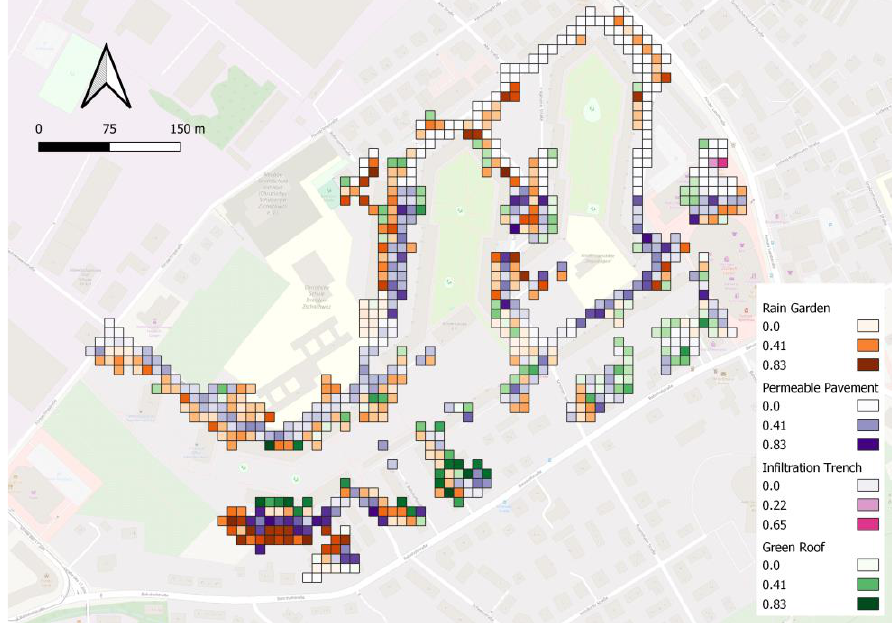
Figure 8. Combined scenario of subcatchment selection for SUDS implementation.